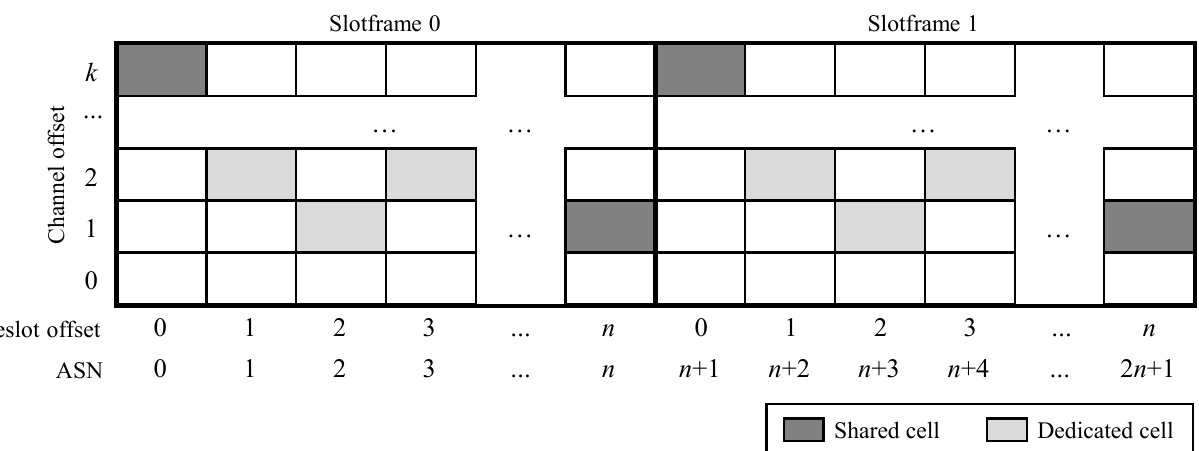
Figure 2. Time-slotted channel hopping (TSCH) slotframe structure.